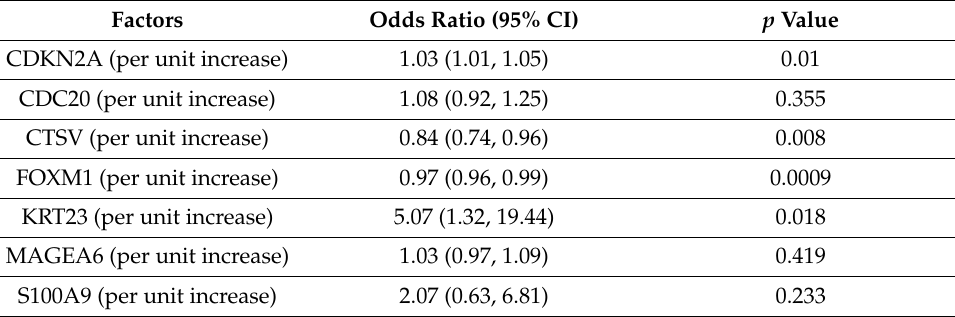
Figure 9. Validation of seven gene subset using qRT-PCR. Real time qRT-PCR validation of genes of CDC20, CDKN2A, CTSV, FOXM1, KRT23, MAGEA6 and S100A9. The qRT-PCR data was analyzed using REST 2009 © (Relative Expression Software Tool), Qiagen, Germantown, MD, USA. Bar represents the standard error mean (SEM) for three biologicals and three technical replicates. Table 4. Univariate analysis of gene expression data on tumor aggressiveness (NMIBC versus MIBC) using logistic